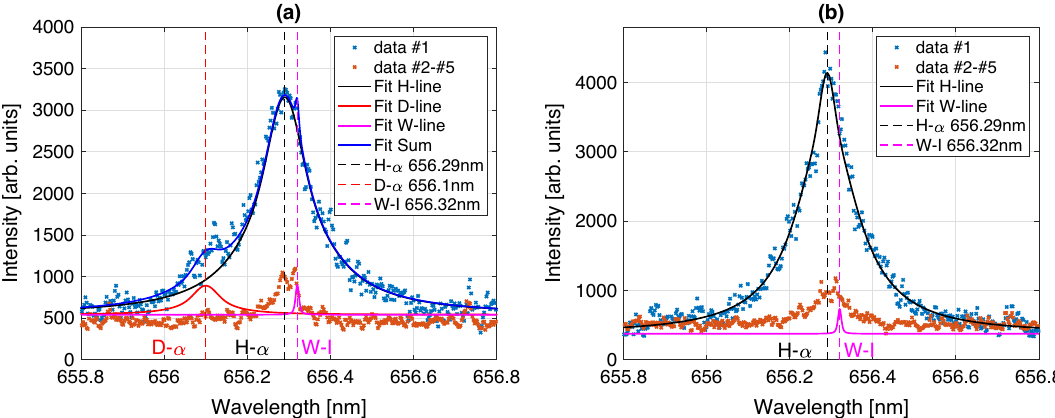
Figure 4. Left: High resolution detection of hydrogen isotope lines ( H α and D α ) in the exposed tungsten tile. Right: Comparable record on a pure tungsten tile. In black, red, and blue pseudo-Voigt fits of the overlapping deuterium and hydrogen spectral line of Balmer- α transition are given. The blue crosses represent the measurement of the first laser pulse (average of 80 positions) and orange the second to fifth pulse at the same positions respectively. Colored in magenta the neutral W-I line at 656.32nm with fixed width and amplitude is given. The applied gate delay and width are chosen as 1.08 µ s .